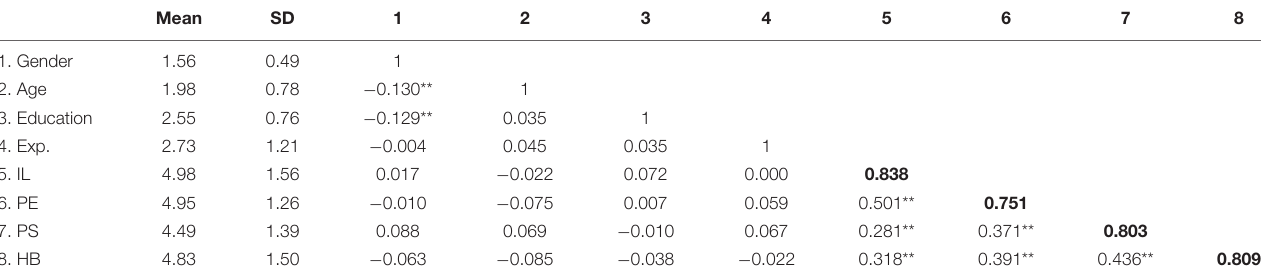
TABLE 3 | Descriptive statistics.